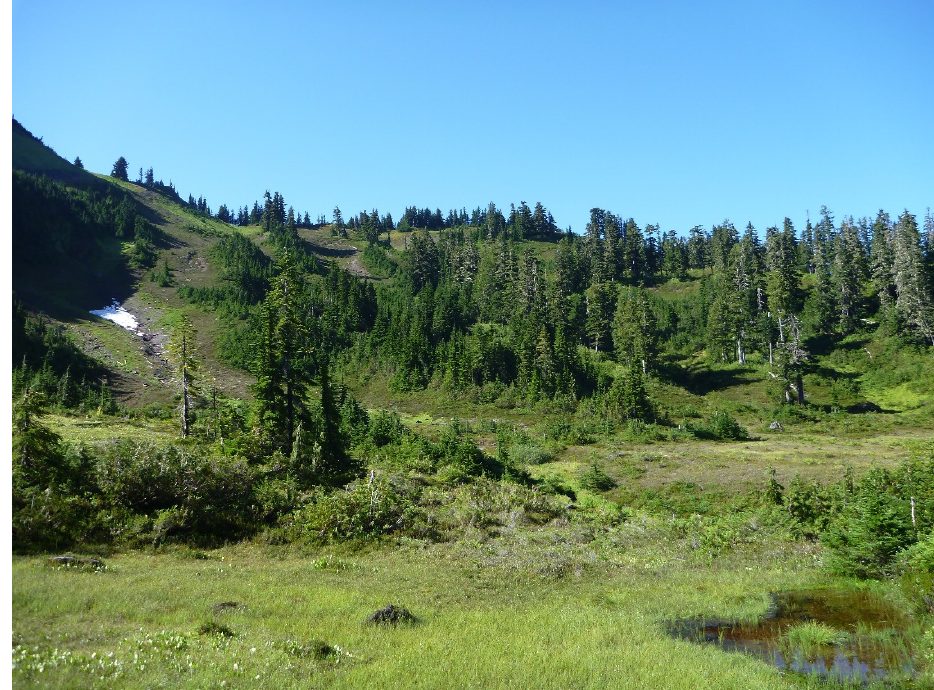
Figure A2. The Grouse Ridge site sits at the head of a glacially carved valley.